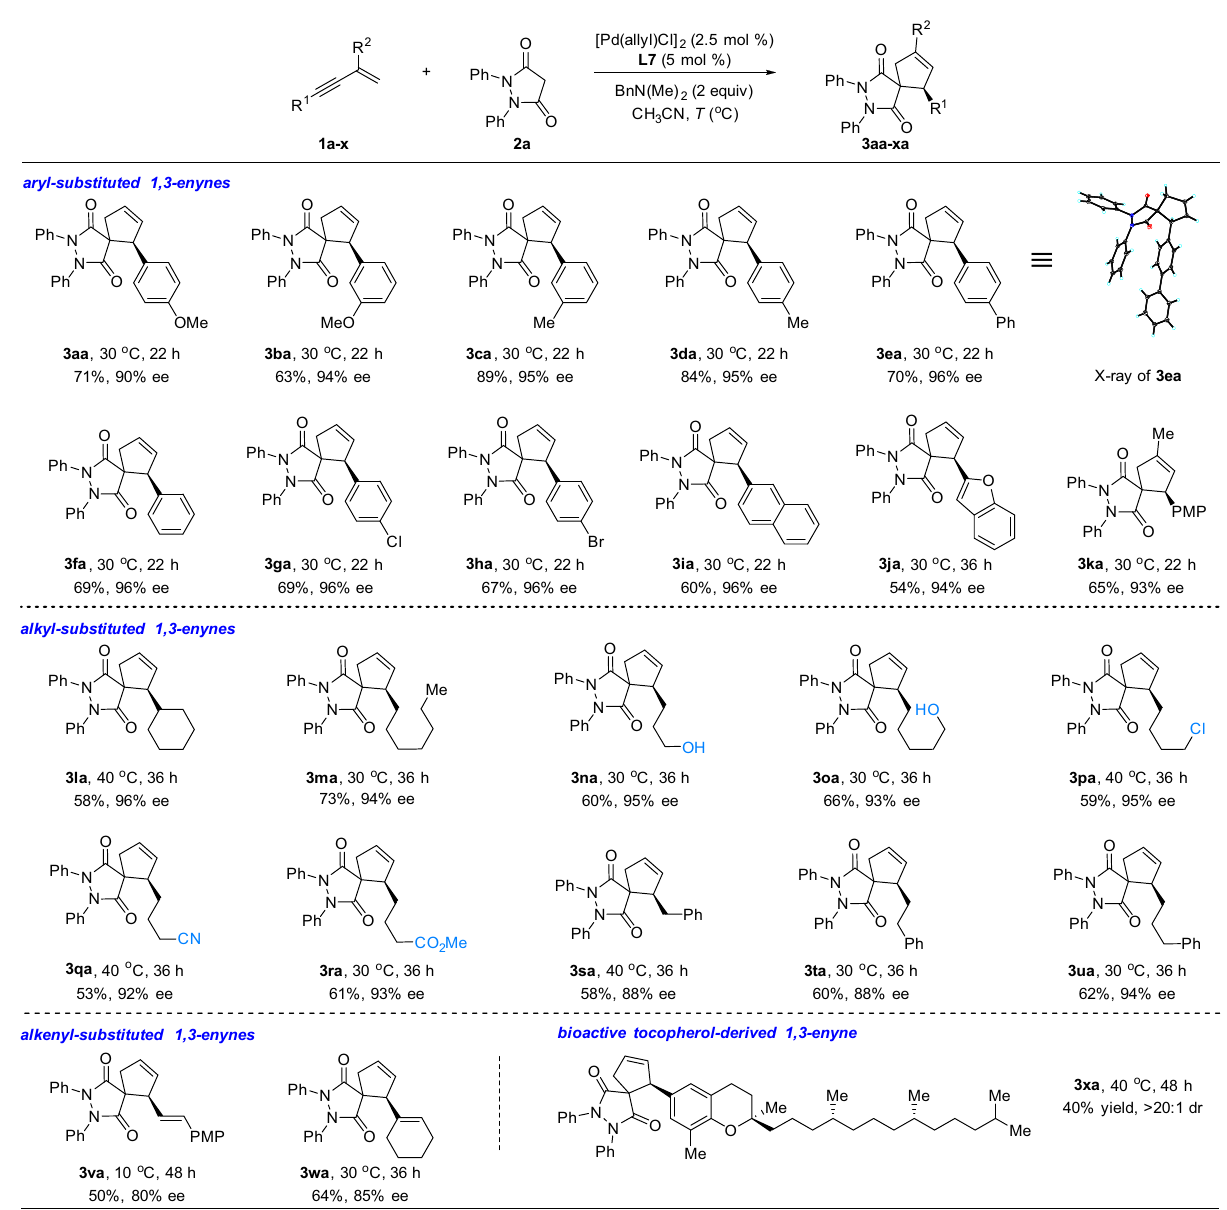
Fig. 2 Pd/WingPhos catalyzed cycloaddition of 1,3-enynes having a double bond with pyrazolidine-3,5-dione. The reactions were carried out on a 0.1- mmol scale. Isolated yields are